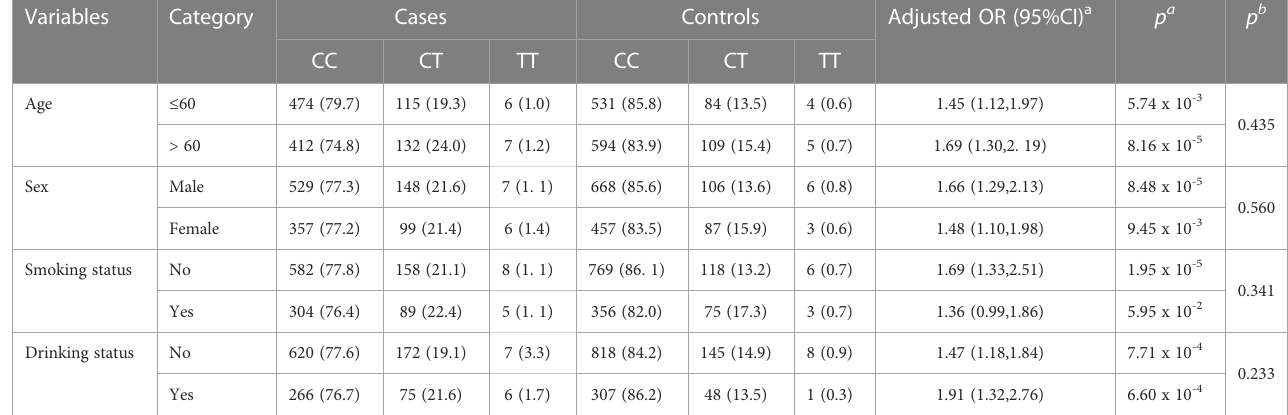
TABLE 2 Strati fi ed analyses of demographic characteristics for the association between PDE1C rs12538364 and colorectal cancer risk.